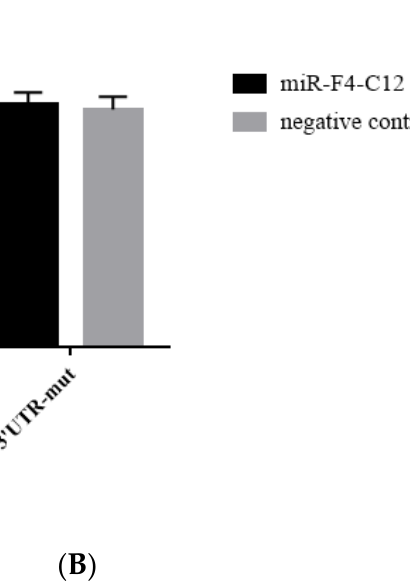
Figure 4. Inhibitory effect of ssc-miR-F4-C12 on PIK3R1 3’UTR using the dual-luciferase system. ( A ) PIK3R1 mRNA sequences from 5 species are aligned 5 ′ to 3 ′ . Potential base pairing between ssc-miR-7134-3p (3 ′ to 5 ′ ) and PIK3R1 is shown in the underline region. ( B ) Cells were transfected with two plasmids containing wild type (wt) or mutant (mut) PIK3R1 3 ′ UTR region and then treated with miR-F4-C12 mimic (black) or negative control (grey). Renilia luciferase values normalized to the Firefly luciferase values. Data represent means ± SD. ** Indicates p < 0.01.